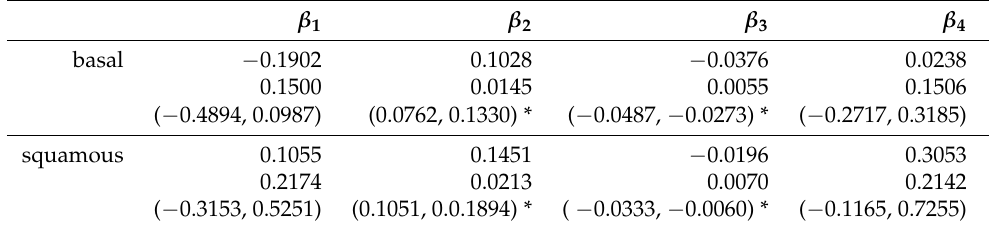
Table A4. Estimation results (posterior mean, posterior standard deviation and 95% credible interval) of the covariate effects for the two types of skin cancers. * indicates statistically significant.